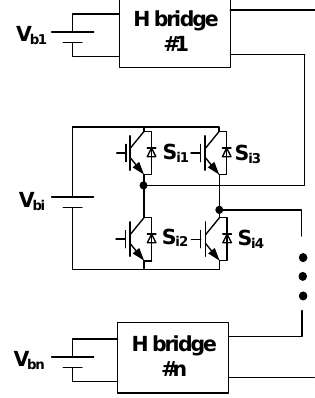
Figure 7. Cascaded H-bridge converter.